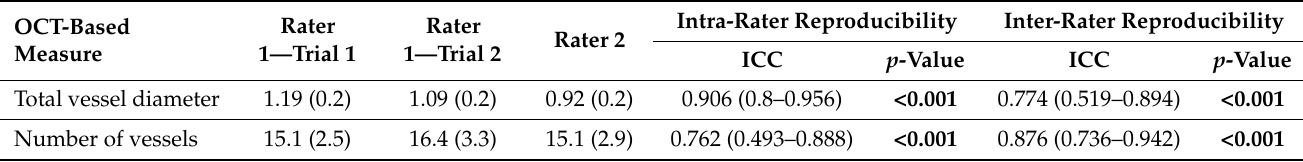
Table 2. Intra- and inter-rater reproducibility of OCT-based vasculature